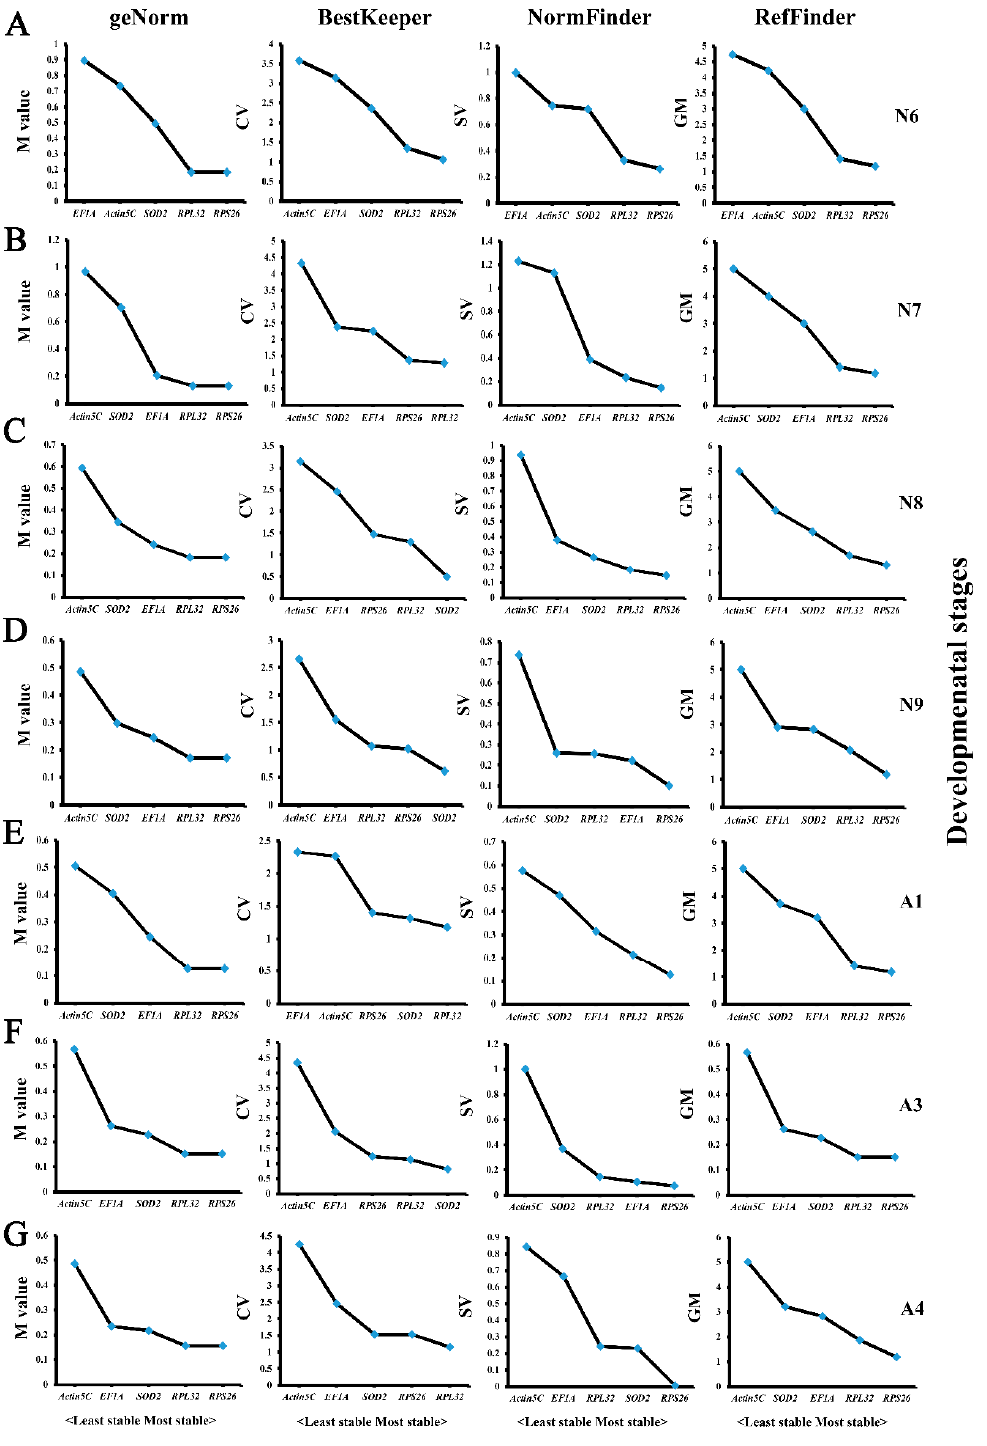
Figure 2. Stable analysis of five candidate genes in different tissues of Thermobia domestica (head, prothorax, mesotho- rax/metathorax, abdomen, and whole body) at the developmental stages of nymphs N6 ( A ), N7( B ), N8 ( C ), and N9 ( D ), and adults A1 ( E ), A3 ( F ), and A4 ( G ) based on four algorithms.